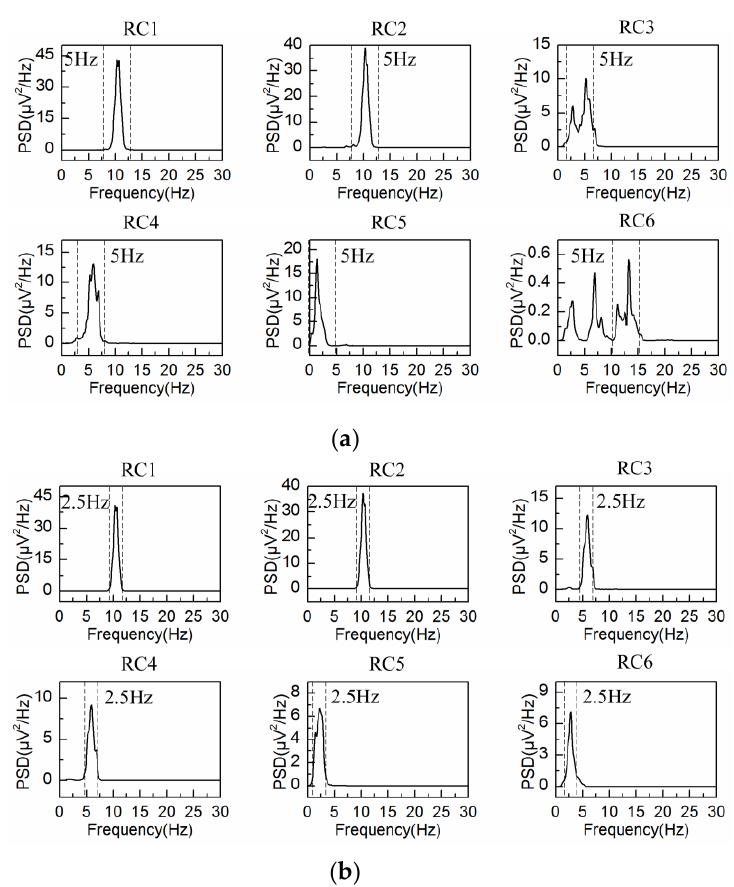
Figure 3. Power spectrum density (PSD) of the first six reconstructed components for the spontaneous EEG signal: ( a ) L = 40; ( b ) L = 80.